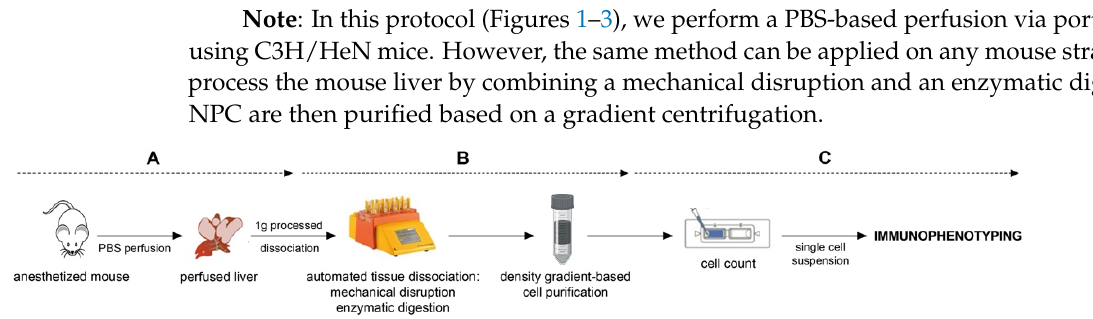
Figure 1. Workflow as a schematic description. ( A ) in vivo manipulation part. ( B ) liver processing. ( C ) downstream procedure. ( C ) downstream procedure. ( C ) downstream procedure.